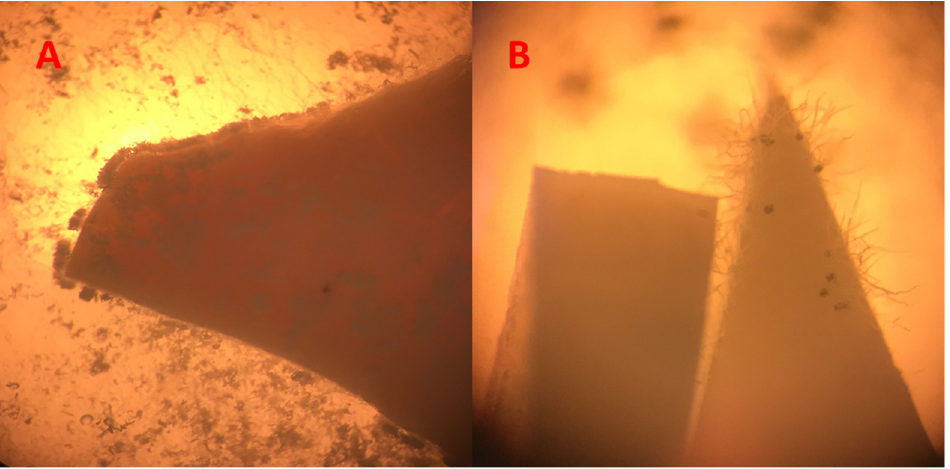
Figure 3. Image ( A ) shows overgrown composites with Chaetomium globosum ; Image ( B ) shows several spores of Aspergillus falconensis , including heads. (64-fold enlargement of two composites during the growth tests). Table 2. Evaluation of the growth strength for the visual assessment, based on DIN EN ISO